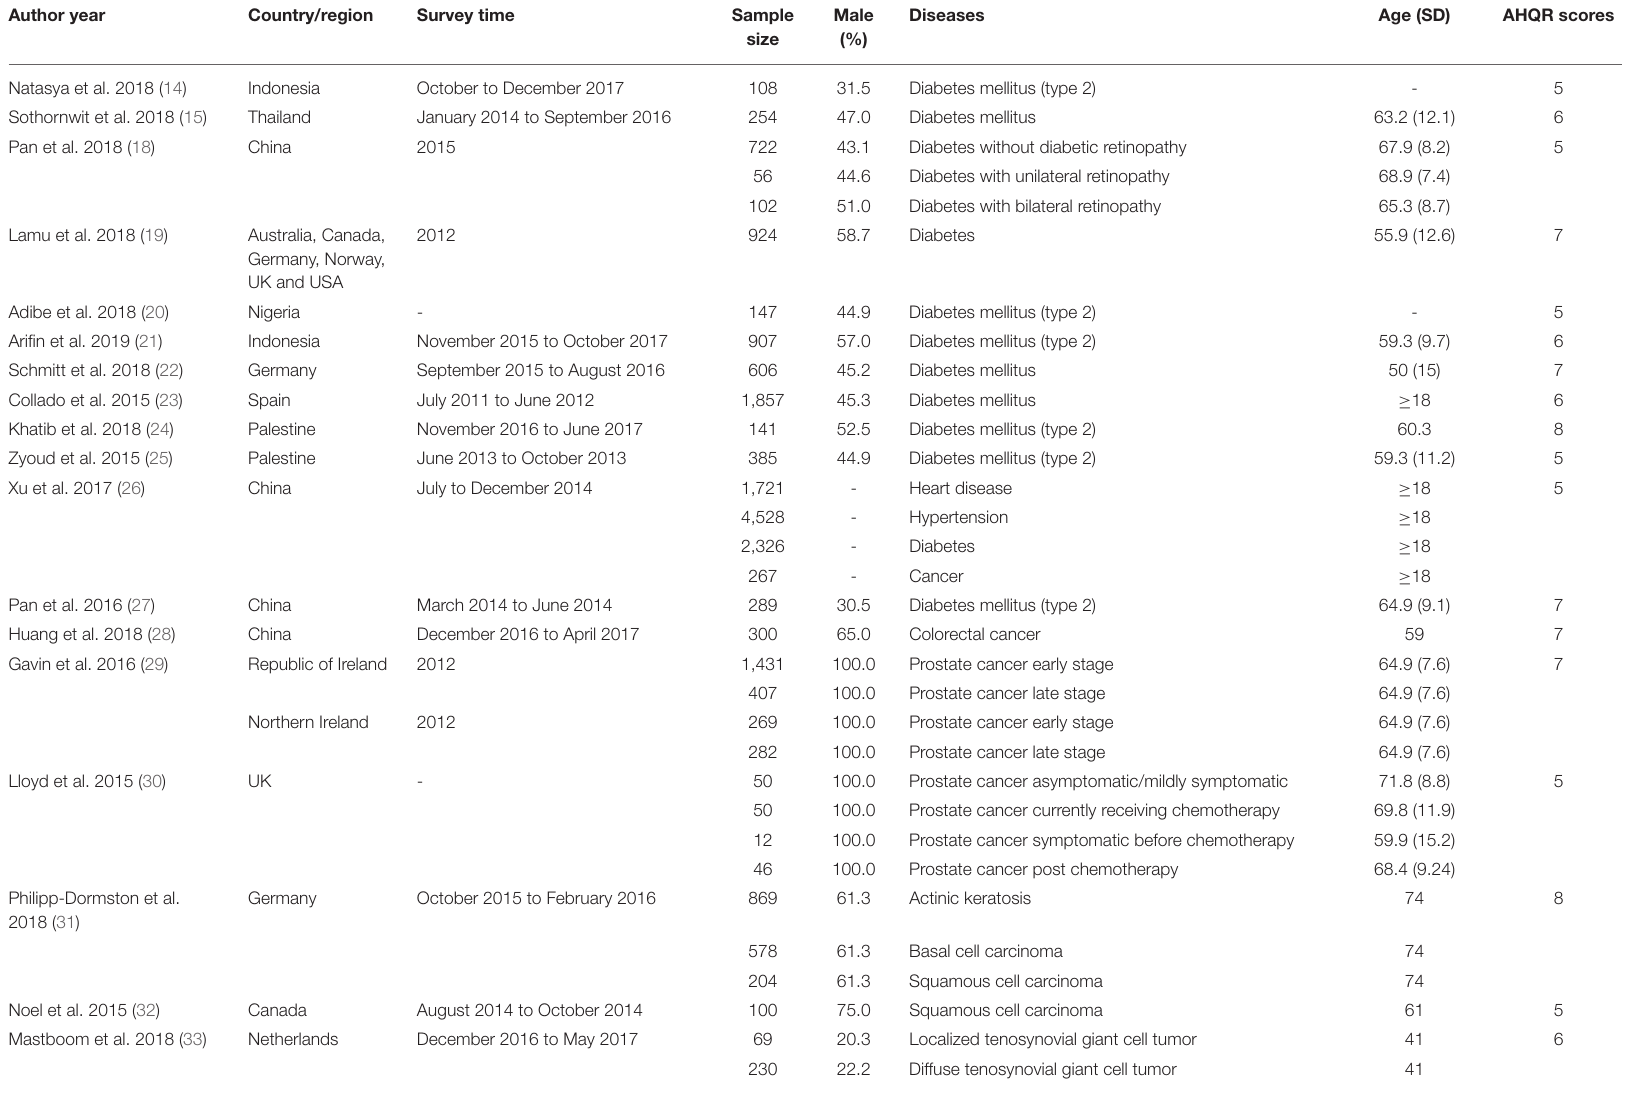
TABLE 1 | Basic characteristics of the included